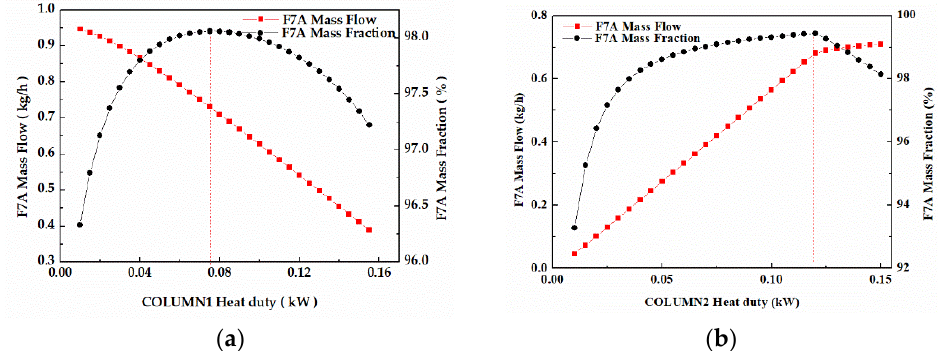
Figure 11. ( a ) Effect of reboiler heat duty on F7A mass fraction and F7A mass flow in stream W1. ( b ) Effect of reboiler heat duty on F7A mass fraction and F7A mass flow in stream D2.